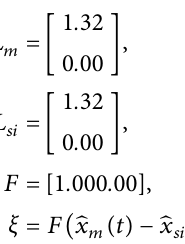
Figure 4 represents the result of the controller. In equation (26), ξ is the controlling function, which controls the behaviour of the (M)-(S) system. Theorem 1 illustrates this in Figure 1, which shows the standardized potential of the (M)-(S) system with its observers. In Figure 5, Theorem 1 illustrates the observer recovery variables for the (M)-(S) systems. Figure 6 explains the error signals between the (M) system and its master observer and between the (S) system and its slave observer. Lm and Ls are the gain matrices for the observer’s respective master and slave systems, poten- tially influencing the master error em(t) and slave error es(t).